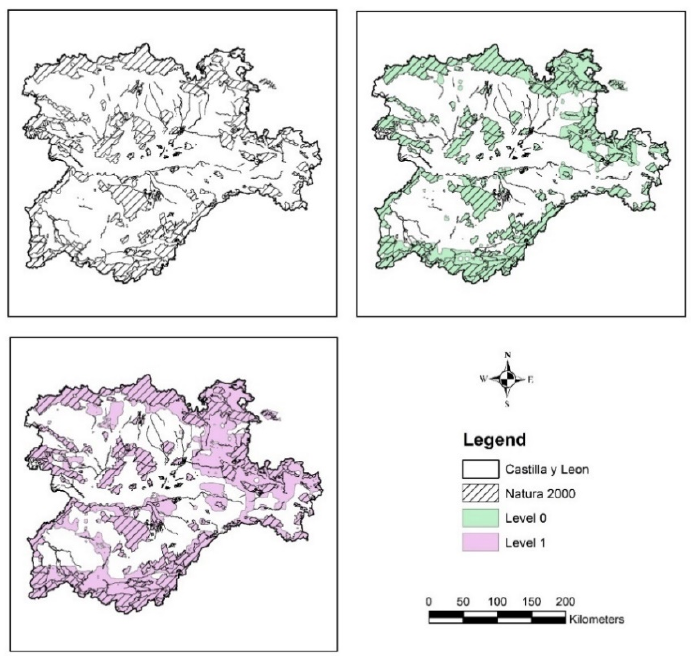
Figure 1. Scenarios considered as input data for the study of connectivity improvement for biodi- versity conservation in Castilla y León region.